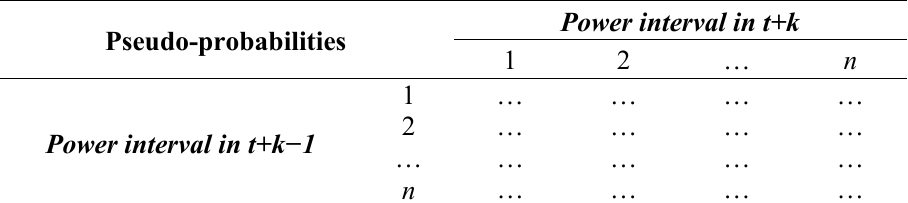
Table 1. Representation of a pseudo-probabilities matrix for n power intervals.